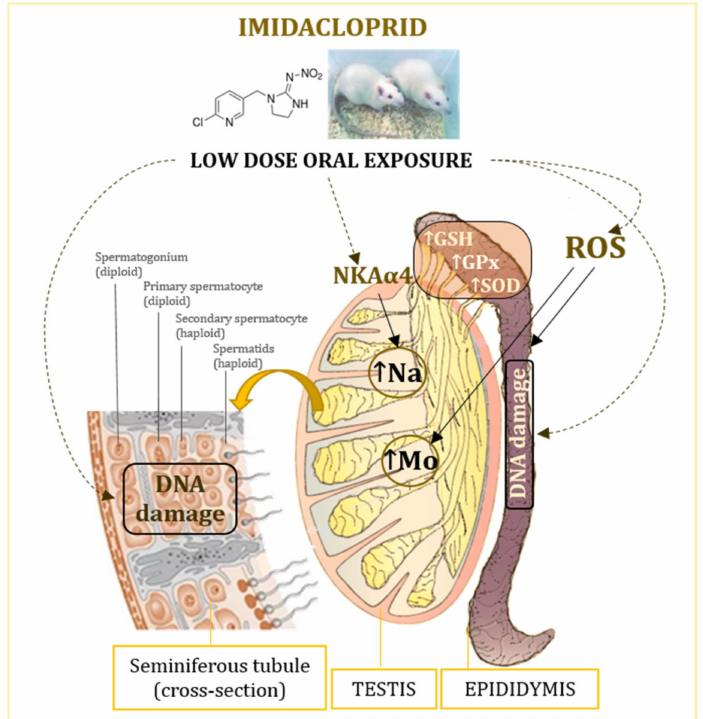
Figure 4. Effects of oral exposure to low doses of imidacloprid on the testis and epididymis of adult male Wistar rats. GSH—glutathione; GPx—glutathione peroxidase; NKA α 4—isoform of the Na, K-ATPase catalytic subunit; ROS—reactive oxygen species; SOD—superoxide